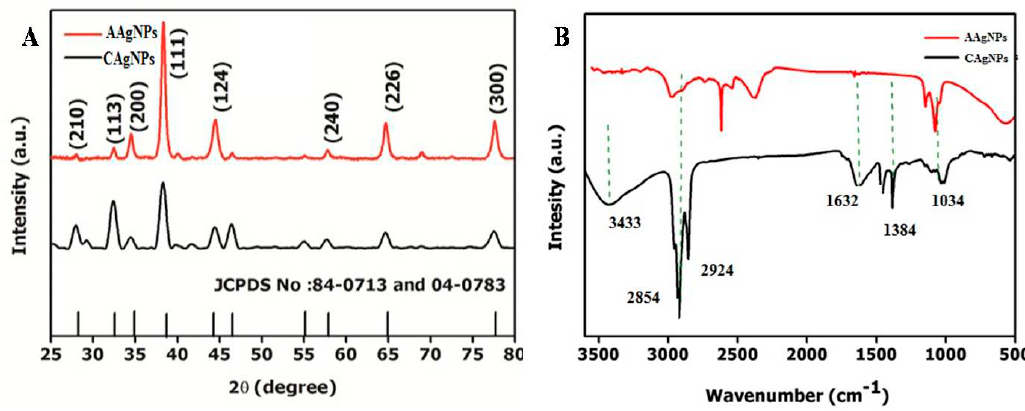
Figure 2. ( A ) X-ray diffraction (XRD) analysis of Catharanthus roseus silver nanoparticles (C Ag NPs) and Azadirachta indica silver nanoparticles (A Ag NPs).( B ) FTIR spectra of Catharanthus roseus silver nanoparticles (C Ag NPs) and Azadirachta indica silver nanoparticles (A Ag NPs).